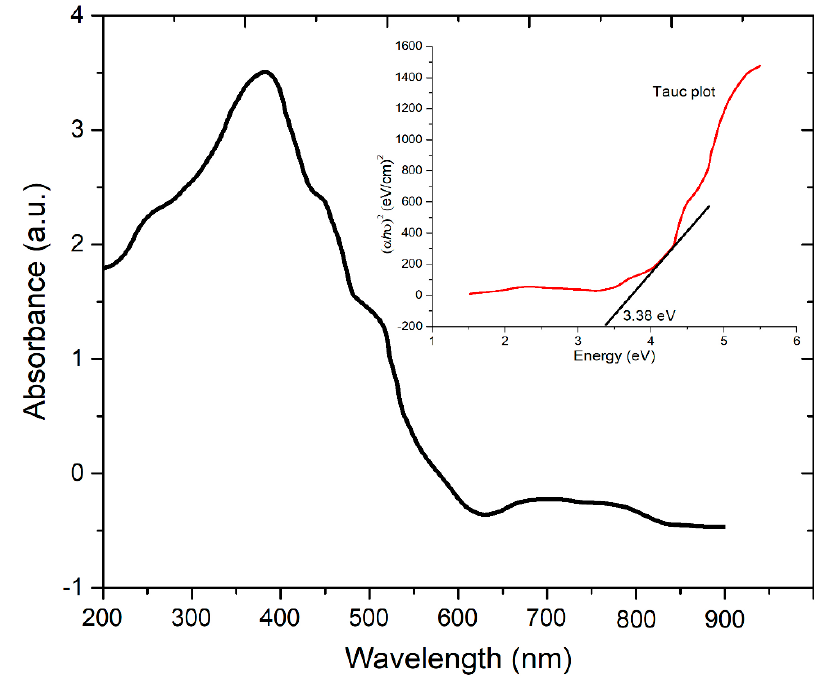
Figure 9. UV-vis spectrum of ZnO suspension of the optimum sample, the inset shows the Tauc plot.